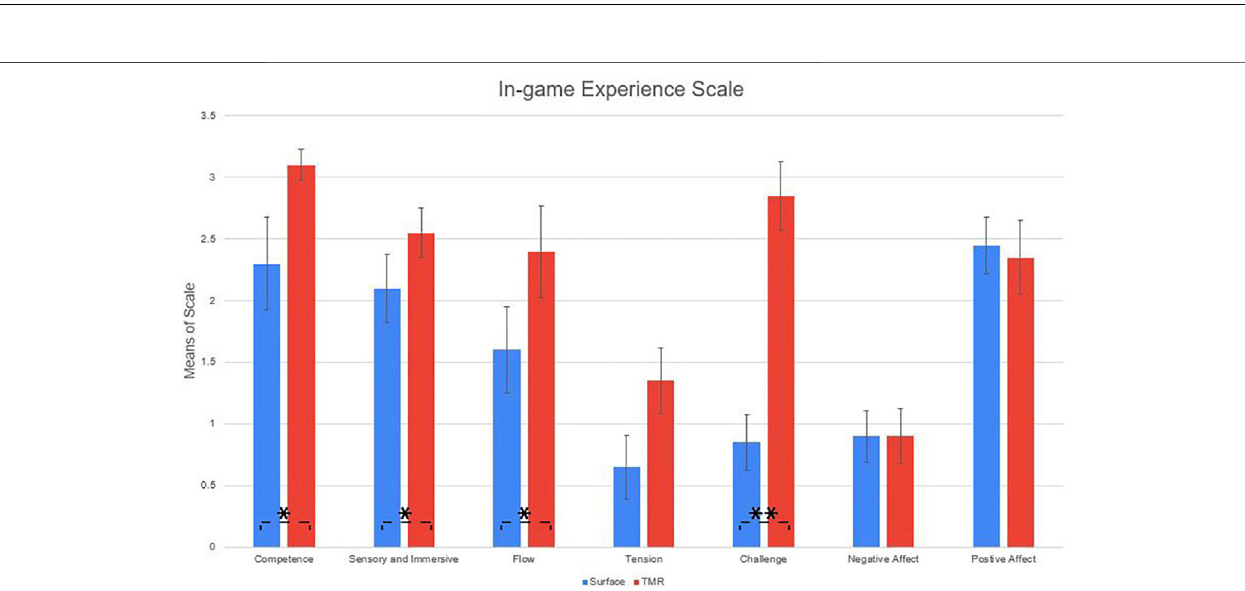
FIGURE 10 | In-game experience scale of surface gesture and TMR interaction technique (* = p < 0.05, ** = p < 0.01). The error bars show standard error.